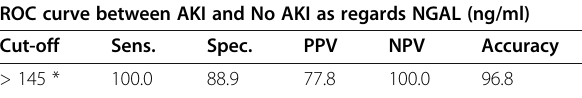
Table 4 Sensitivity and specificity of plasma NGAL (at cut-off value > 145 ng/ml) ROC curve between AKI and No AKI as regards NGAL (ng/ml) Cut-off Sens.